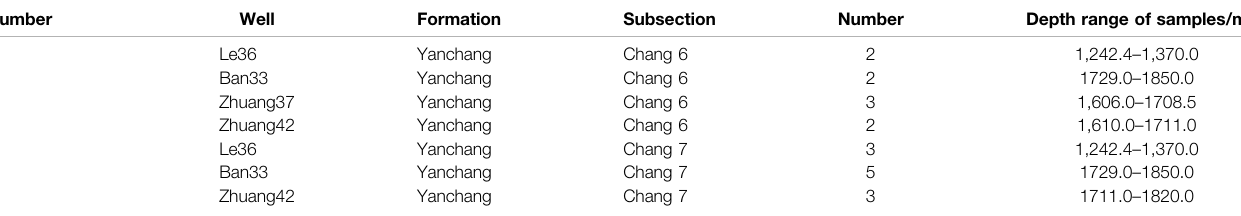
TABLE 4 | The number, well name, formation, subsection, and depth range ofsamplesused to determine rare earth elementcontent. See Figure 1 for the location of